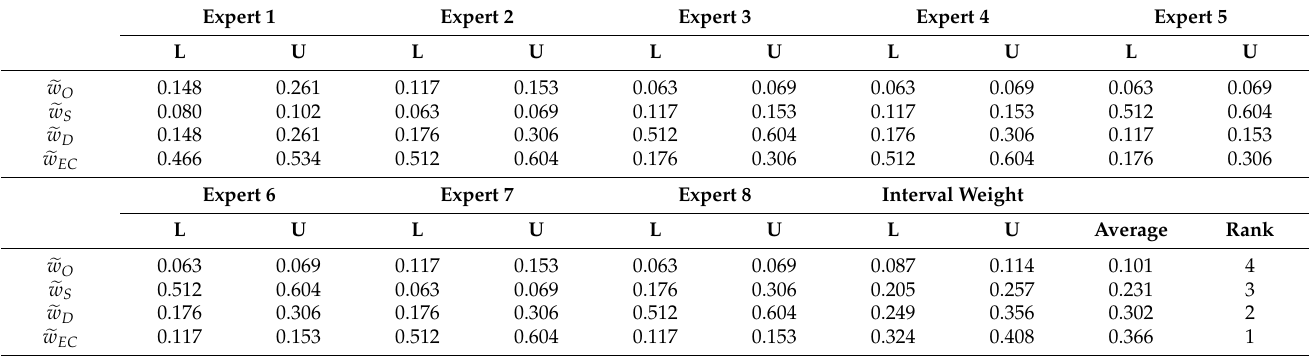
Table 7. Weights of the RPN elements (O, S, D, and